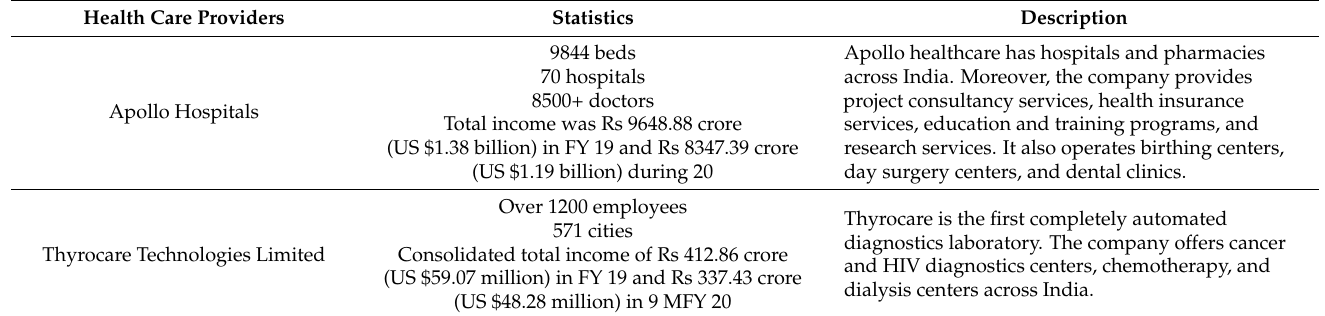
Table 4. Healthcare hubs in